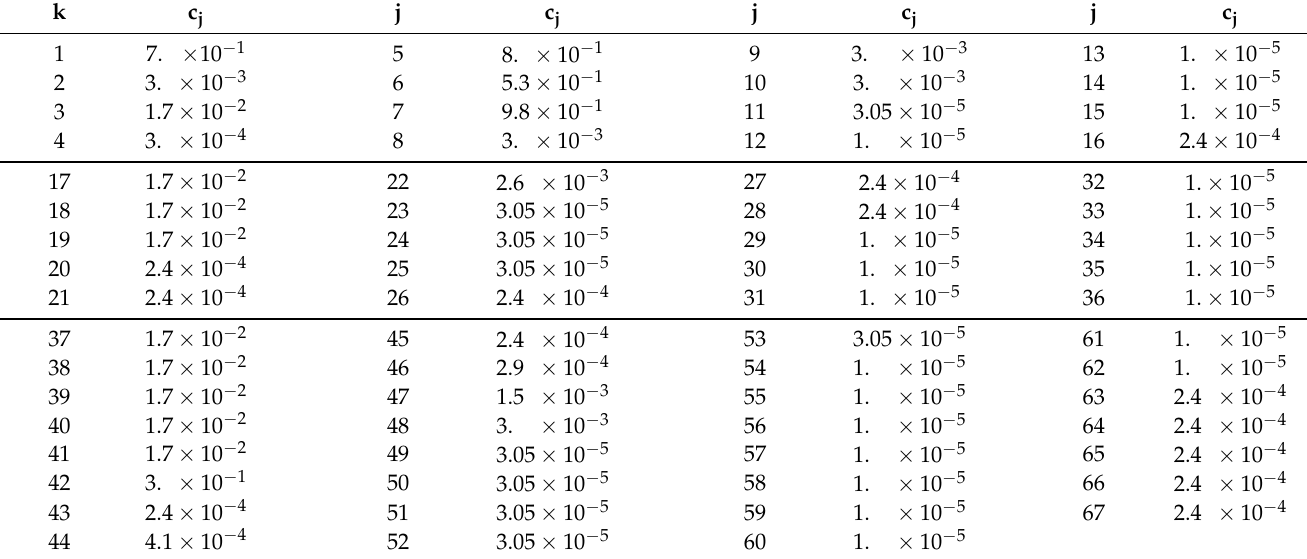
Table 4. Coefficients c j in the chemical reactions in